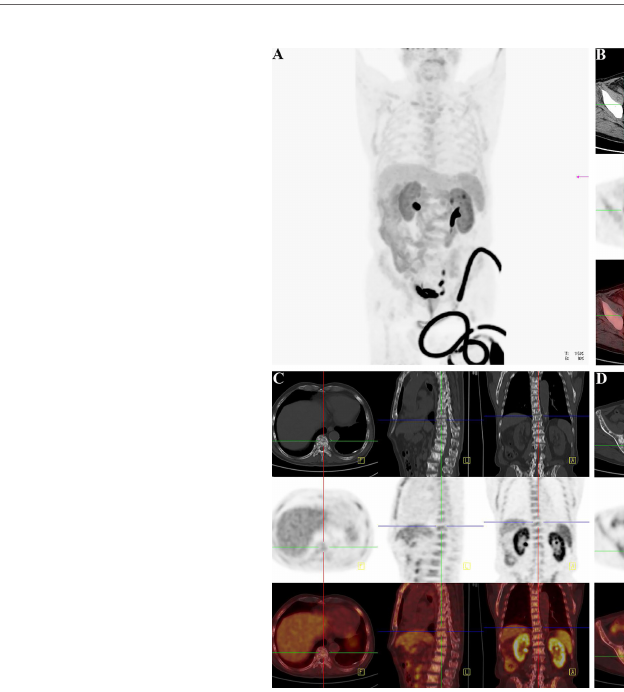
FIGURE 9 | Another clinical replicate case from PET-CT in the case of 76-year-old man. (A) Gross view of coronary position detected by PET-CT. Similarly, the darker the color was, the higher the intake of tracer in the corresponding body part. Since the tracer was excreted through urine, the organs of urinary system were perceptibly high take of tracer. However, the prostate indicated abnormal high intake with dark tracer accumulation, consistent with local lesion of PCa. At the lower right corner of the picture, the spinning black “ wire ” should be the indwelling urine catheter and the urine with tracer inside. The bladder of the patient was not full, for the existence of urine catheter led the urine into the urine collection bag instantly. (B) The direction cross focused on the enlarged lymph node on the right side of the external iliac vessel. From the view of regular CT, the fi rst row exhibited enlarged lymph node in right side of the external iliac vessel with the same density of soft tissue, and it displayed its neighboring tissues and bone structure. The speci fi c nature of enlarged lymph node was unclear. The high-intake lesion on the right side of the external iliac vessel was also detected by the probe of 18 F-Alfatide II in the second row from three directions, which suggested convincing evidence of lymphatic metastasis of PCa. Meanwhile, there were other two high intake points in the same slice of axial direction. As the association of the fi rst and second rows, the third row demonstrated the highlighting point on the right side of the external iliac vessel was enlarged lymph node of metastasis while the other two points were a primary tumor lesion in the prostate and a section of urine catheter in vitro according to their position. Therefore, except for the tracing of bone metastatic lesion, the utilization of detecting lymph node of metastasis by the probe of 18 F-Alfatide II should also be available. (C) The direction cross focused on the metastatic lesion in the lumbar 1 vertebra. The fi rst, second, and third rows corresponded to the view of regular CT, PET-CT ( 18 F-Alfatide II), and mergence in three directions in the lesion of the lumbar 1 vertebra. The fi rst row presented the high density of bone cortex in the lumbar 1 vertebra, which also tallied with the feature of bone metastasis in PCa. The second row showed the abnormal high intake lesion of 18 F-Alfatide II in the lumbar 1 vertebra, hinting the malignant tendency of this lesion. As the mergence of the fi rst and second rows, the third row displayed the abnormal lesion in the lumbar 1 vertebra through high brightness signal. (D) The direction cross focused on the metastatic lesion behind the left ilium. The fi rst, second, and third rows separately revealed the observed lesion behind the left ilium in the view of regular CT, PET-CT ( 18 F-Alfatide II), and combination of regular CT and PET-CT in three directions. In the fi rst row, we could fi nd the unusual bone hyperplasia behind the left ilium. Then, the high intake of tracer in the views of PET-CT ( 18 F-Alfatide II) revealed malignant metastatic lesion. The third row provided the combination of the fi rst and second rows that we could discover corresponding region of another bone metastatic